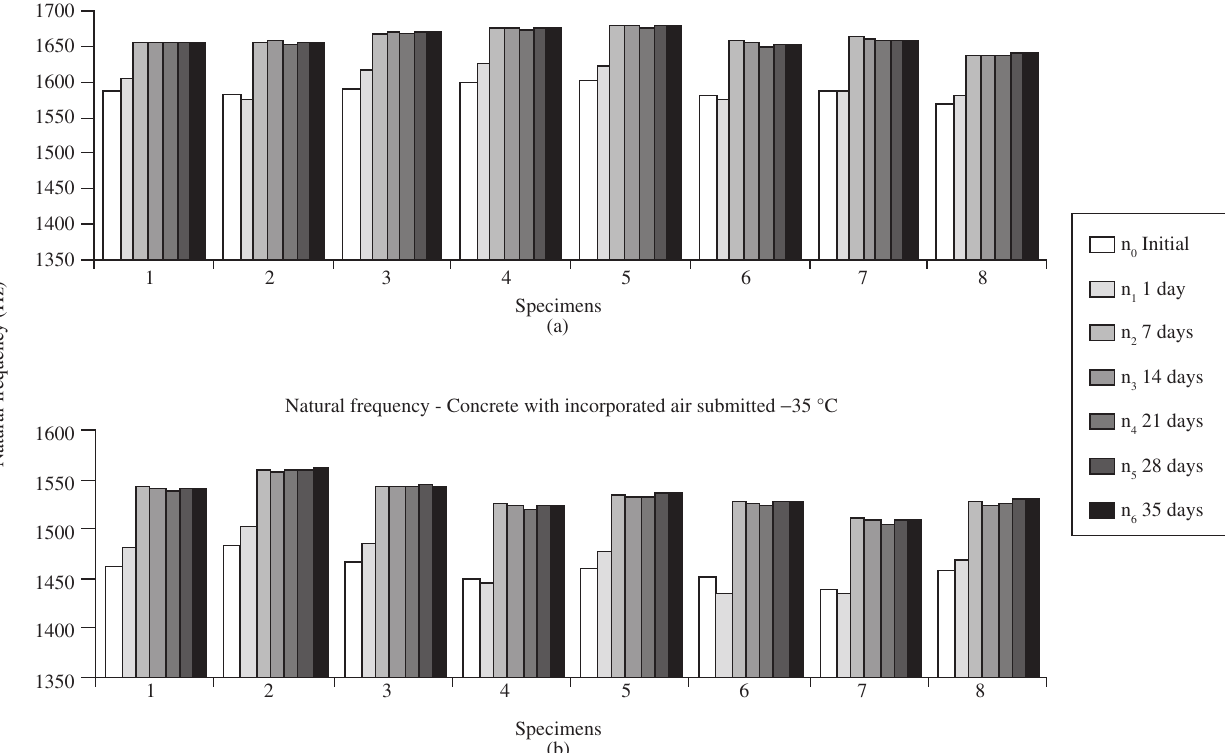
Figure 10. Values of natural frequency (n) for the specimens of concrete tested at –35°C: a) concrete without incorporated air; and b) concrete with incorpo- rated air (6 ± 1%). Source: Lima 9